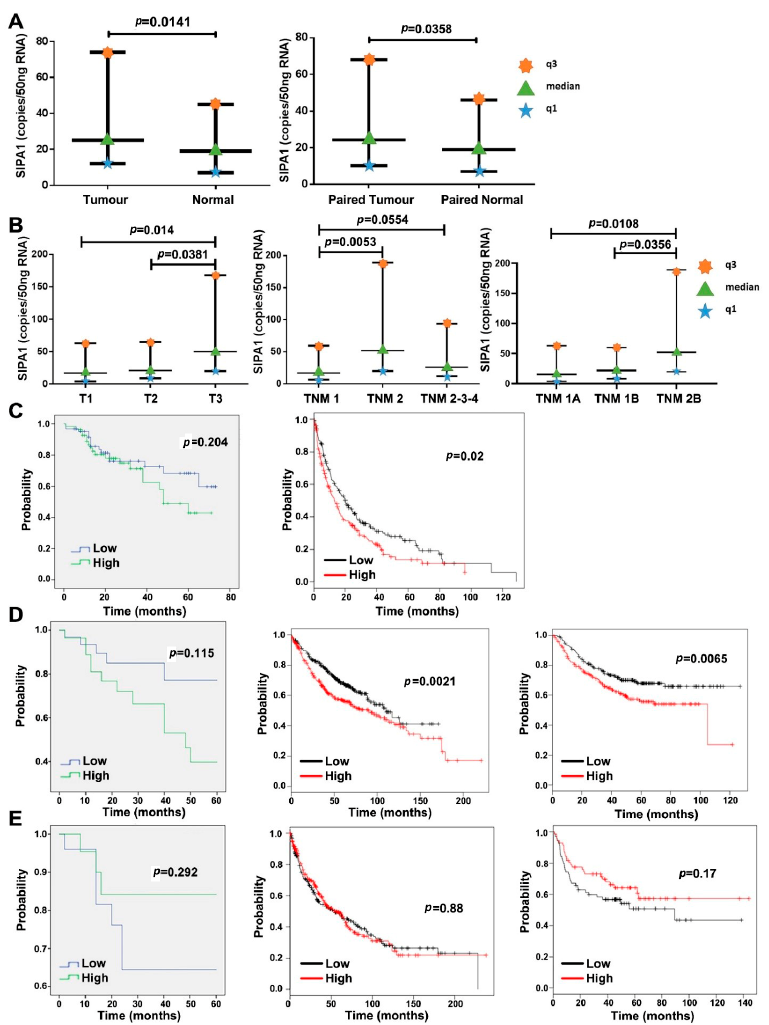
Figure 1. Expression level of SIPA1 in lung cancer and its clinical relevance. ( A ) Transcript level of SIPA1 in lung cancer and adjacent normal lung tissue (left) and paired adjacent normal lung tissue (right). ( B ) Transcript level of SIPA1 in different T stage, TNM stage and TNM substage lung cancer. (A&B-SIPA1 level was evaluated by copy number/50 ng RNA, and Mann-Whitney U test was selected to determine significance).( C ) Kaplan-Meier survival models of correlation between SIPA1 transcript levels and survival of all lung cancer patients from Peking cohort-Overall survival (OS) (left), and post progression survival (PPS) (right). ( D ) Kaplan-Meier survival model of correlation between SIPA1 transcript levels and survival of lung adenocarcinoma patients. Left: SIPA1 transcript levels with OS in patients from Peking cohort; middle: SIPA1 transcript levels with OS in patients from KMplot website; right: SIPA1 transcript levels with PFS in patients from KMplot website. ( E ) Kaplan-Meier survival model of correlation between SIPA1 transcript levels and survival of lung squamous cell carcinoma patients. Left: SIPA1 transcript levels with OS in patients from Peking cohort; middle: SIPA1 transcript levels with OS in patients from KMplot website; right: SIPA1 transcript levels with PFS in patients from KMplot